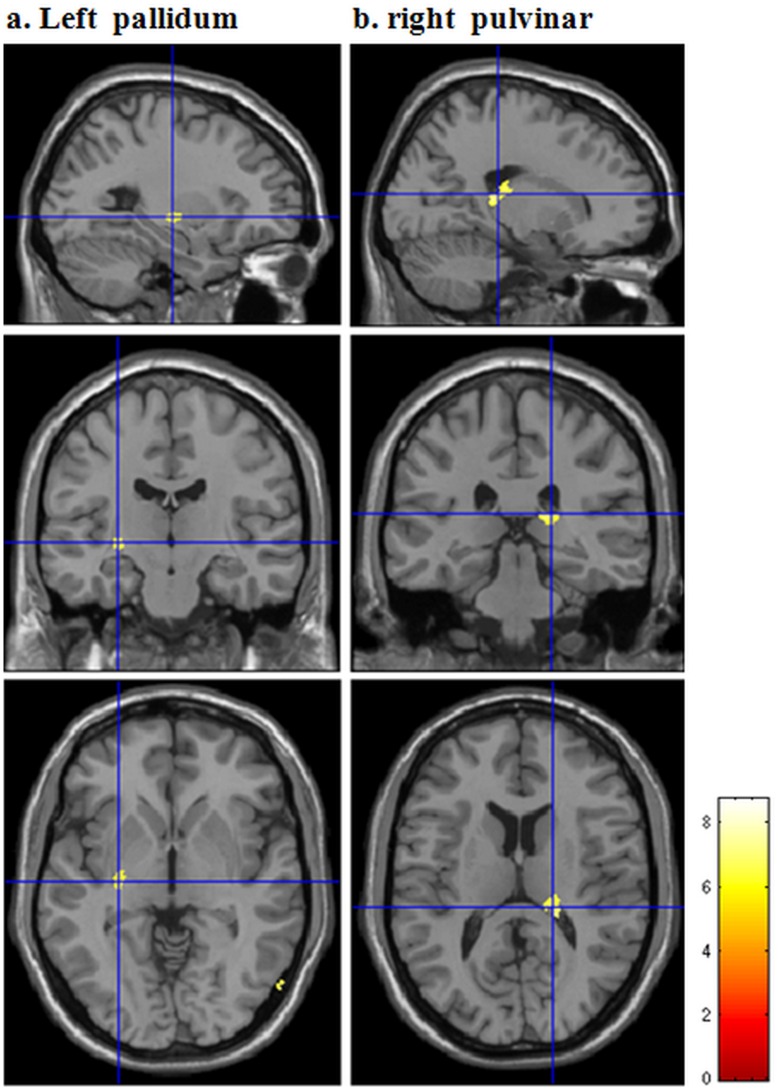
Regional gray matter volume changes in trauma survivors without PTSD compared with normal controls.The significant reduction region in trauma survivors without PTSD compared with normal controls (n = 20) are rendered onto the standard T1 template of Montreal Neurological Institute. Compared with normal controls, trauma survivors without PTSD (n = 10) had significantly decreased gray matter volume in left pallidum and right pulvinar. (p<0.05, FWE corrected, with k>50 voxels).